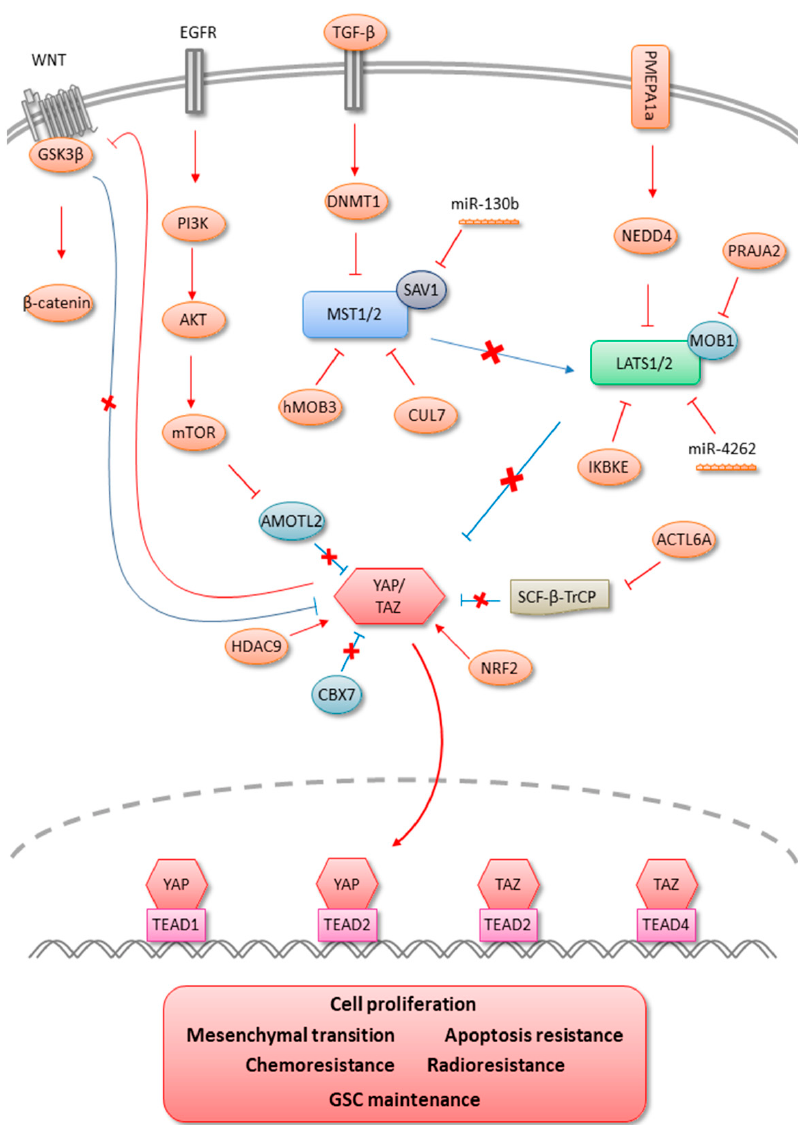
Figure 2. Modulations of Hippo signaling in gliomas.